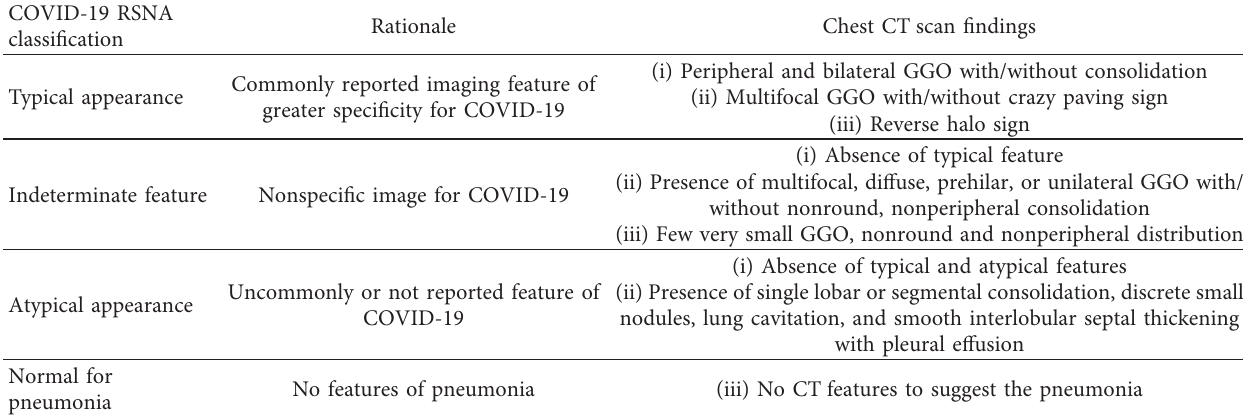
Table 1: RSNA criteria for COVID-19 pneumonia (adopted from reference